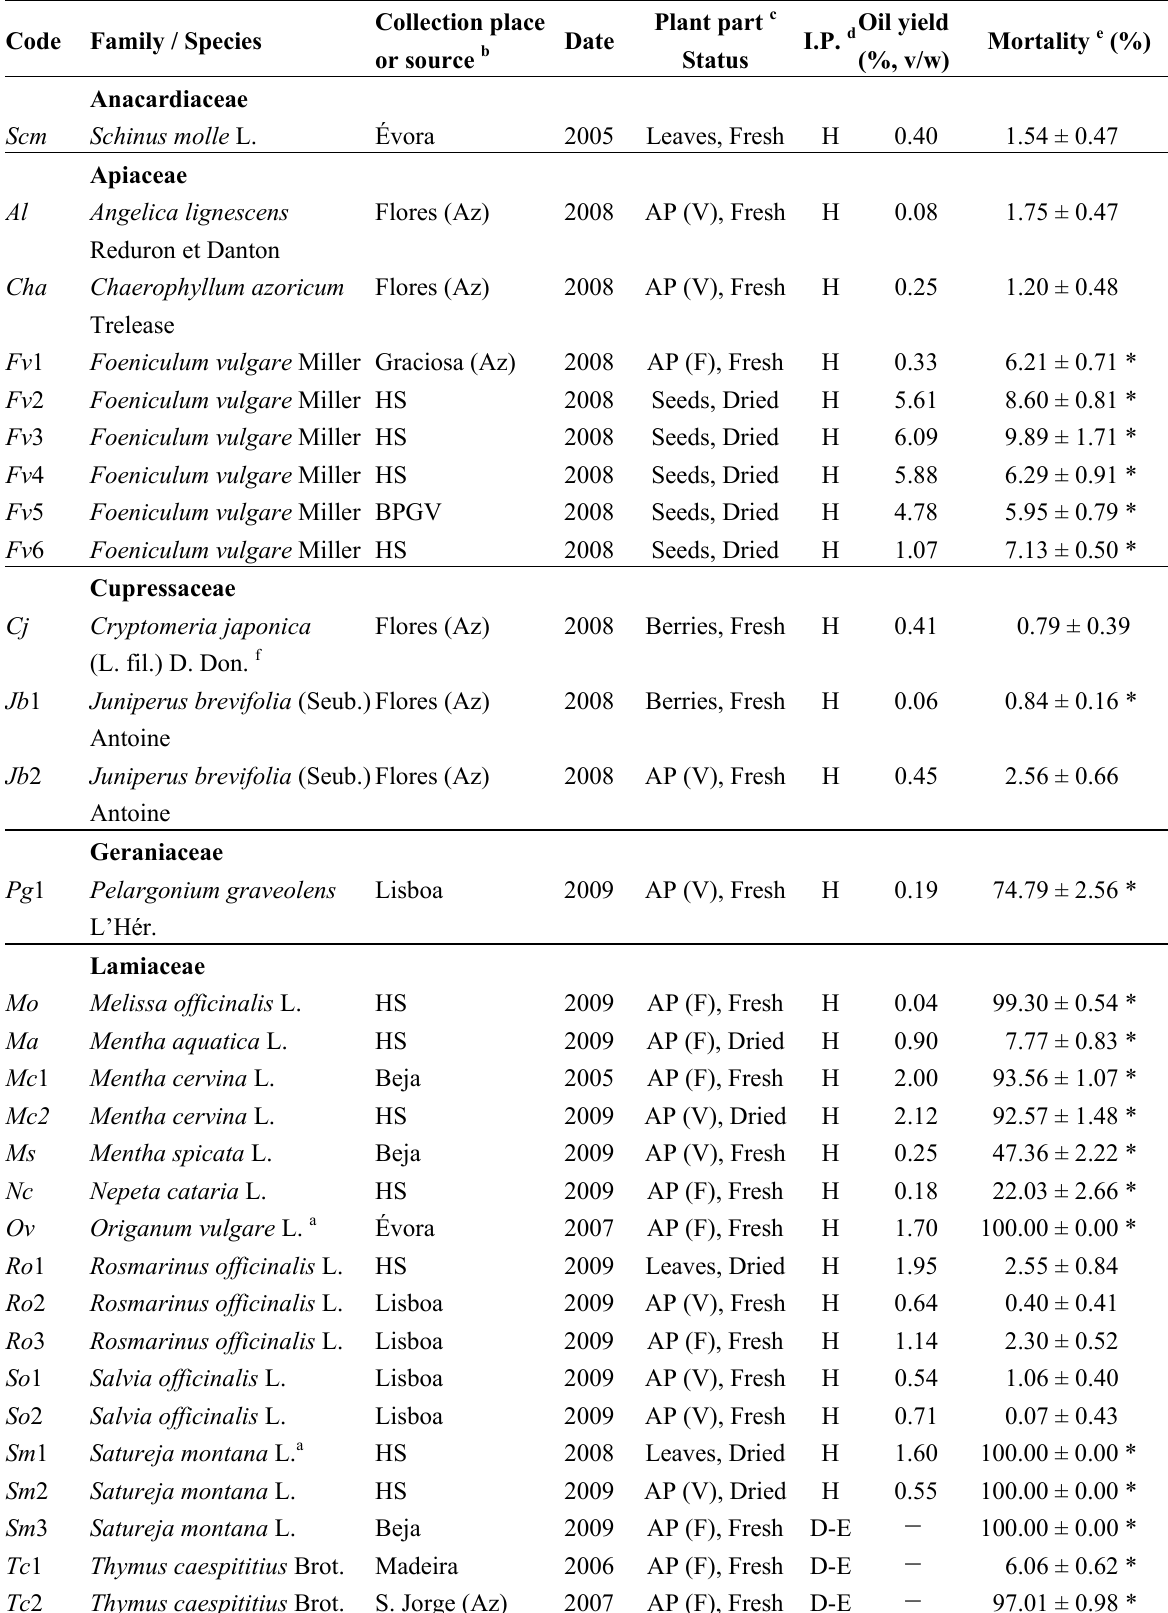
Table 3. Nematicidal activity of 52 essential oils against Bursaphelenchus xylophilus exposed for 24 h to a 2 mg/mL